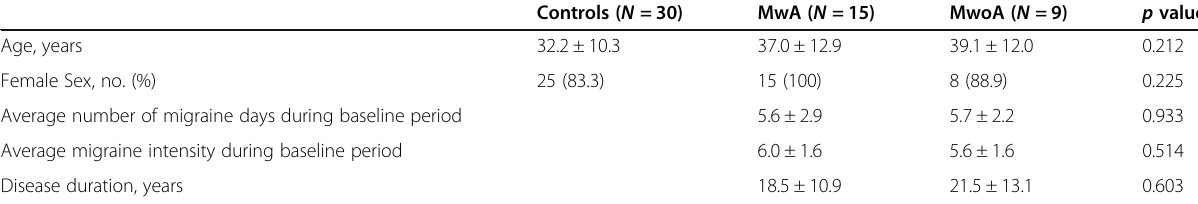
Table 1 Baseline characteristics of controls, episodic migraineurs with aura and episodic migraineurs without aura